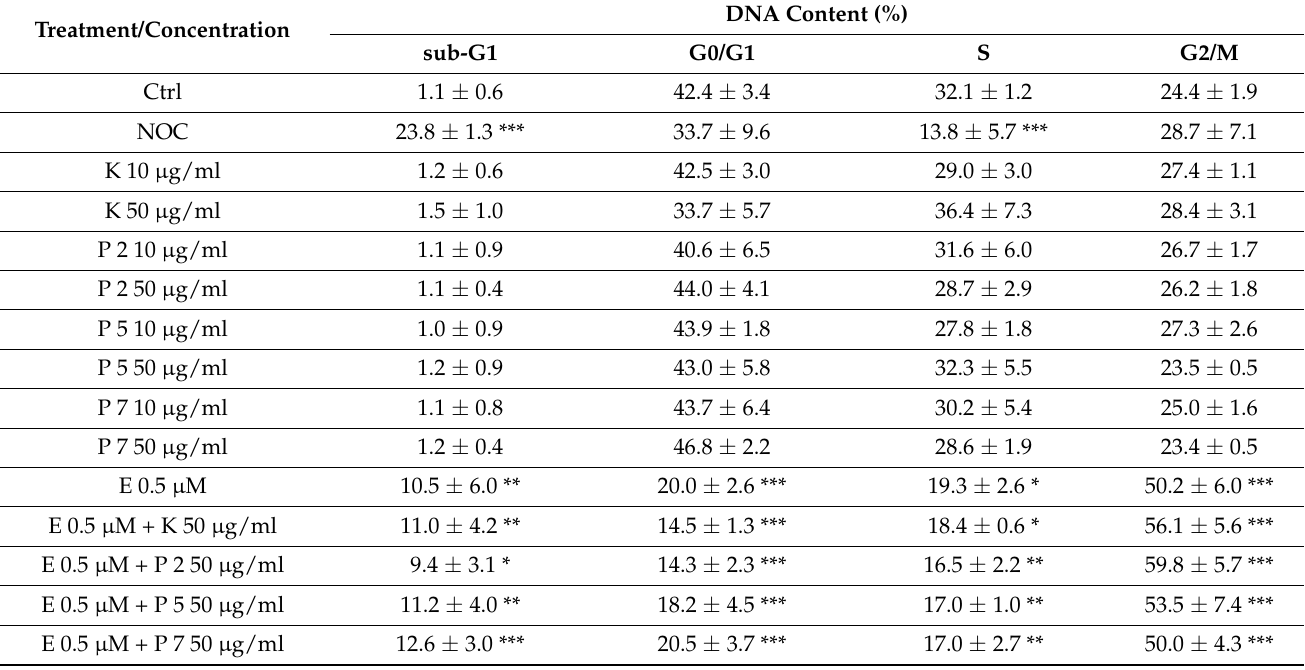
Table 1. Cell cycle distribution measured by flow cytometry using a staining with propidium iodide in HL-60 cells incubated for 24 h at 37 ◦ C with 0.5 µ M etoposide (E) and 10 or 50 µ g/mL kaempferol (K), P2, P5 and P7 derivatives. The cells incubated with 100 ng/mL nocodazole (NOC) for 24 h at 37 ◦ C were positive control. DNA Content Treatment/Concentration